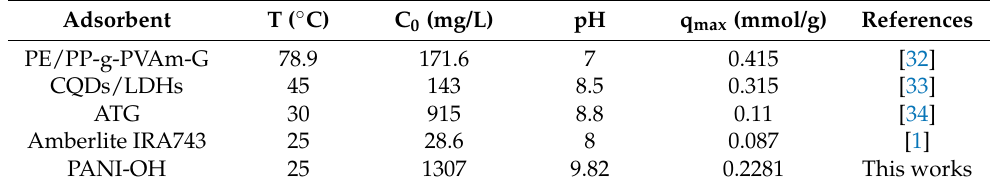
Table 2. Comparisons of the maximum adsorption capacity between our work and related reports in the